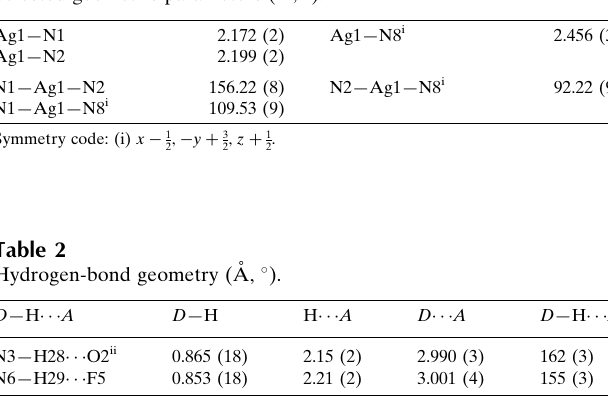
Selected geometric parameters (A˚ , (cid:3) ).